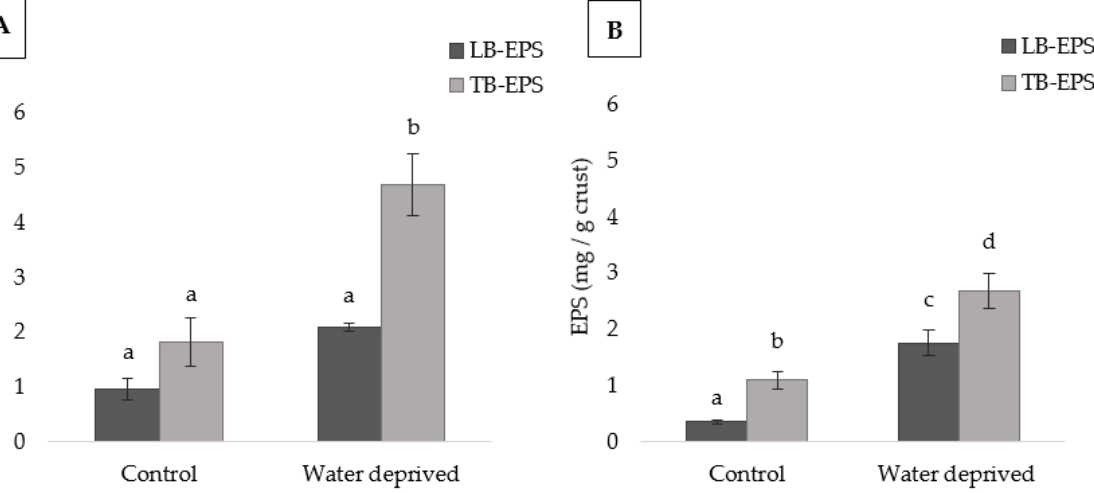
Figure 1 . Chlorophyll a content in cyanobacterial biocrusts (values represent the mean of N = 3, error bars represent SD). Different letters represent significant differences ( p < 0.05).